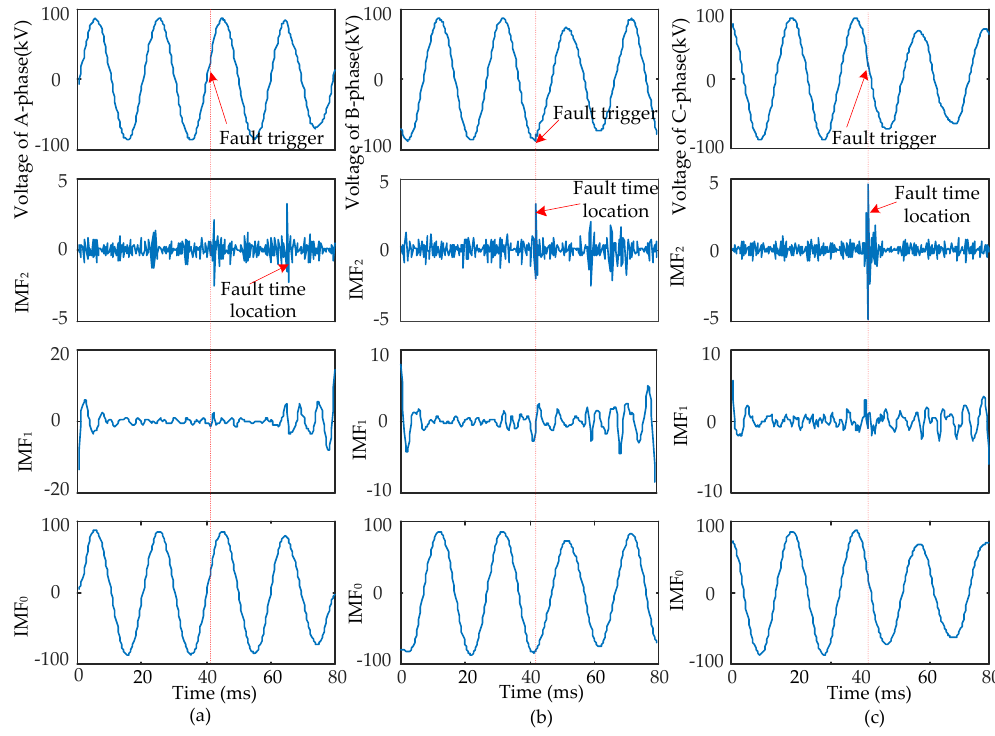
Figure 15. Actual BC fault signal’s modes extracted by the EWT are shown as follows: ( a ) A-phase voltage and its IMFs; ( b ) B-phase voltage and its IMFs; ( c ) C-phase voltage and its IMFs.